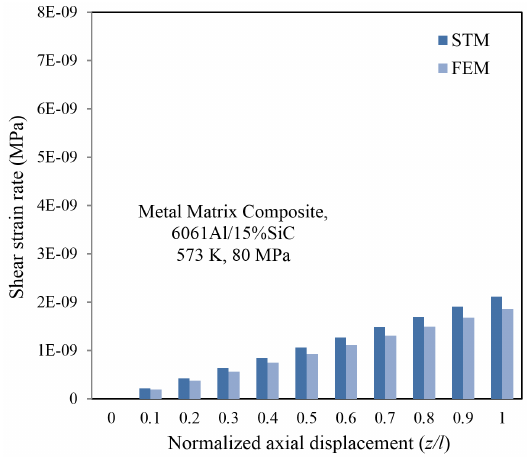
Figure 4. Behavior of the shear stress at r = a + δ by FEM and STM (Analytical, present work).